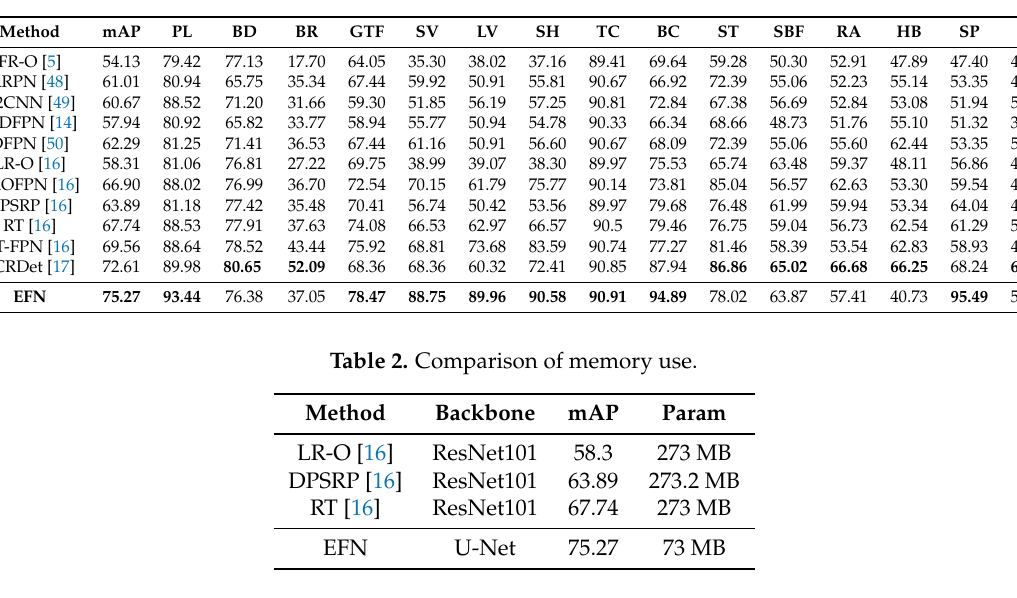
Table 3. Comparisons with the state-of-the-art methods on HRSC2016.